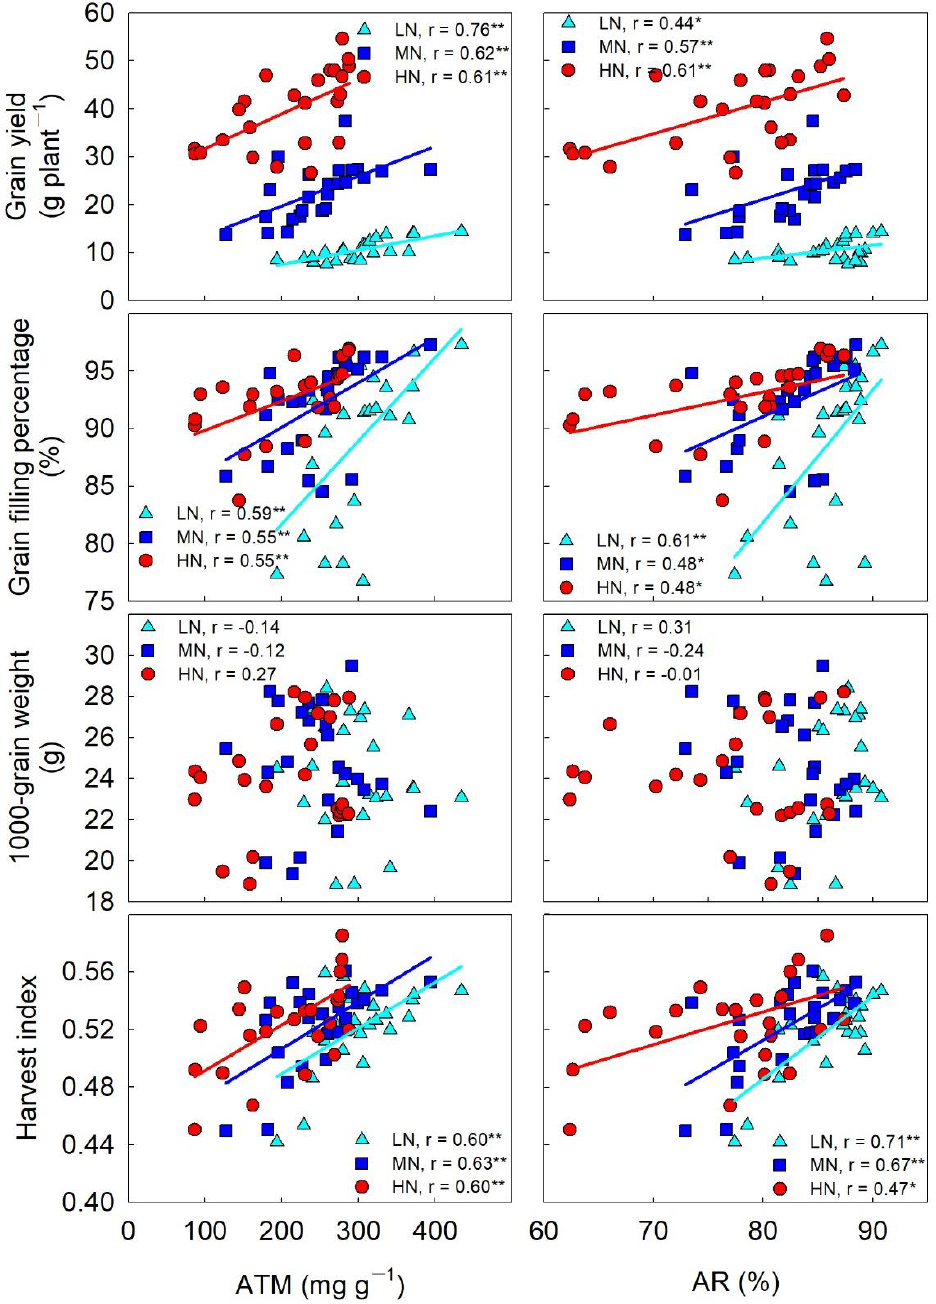
Figure 4. Correlations of yield-related traits with stem ATM and AR. * and **, significant at p < 0.05 and at p < 0.01, respectively. LN, low nitrogen; MN, medium nitrogen; HN, high nitrogen; ATM, apparent transferred mass; AR, apparent transferred ratio.